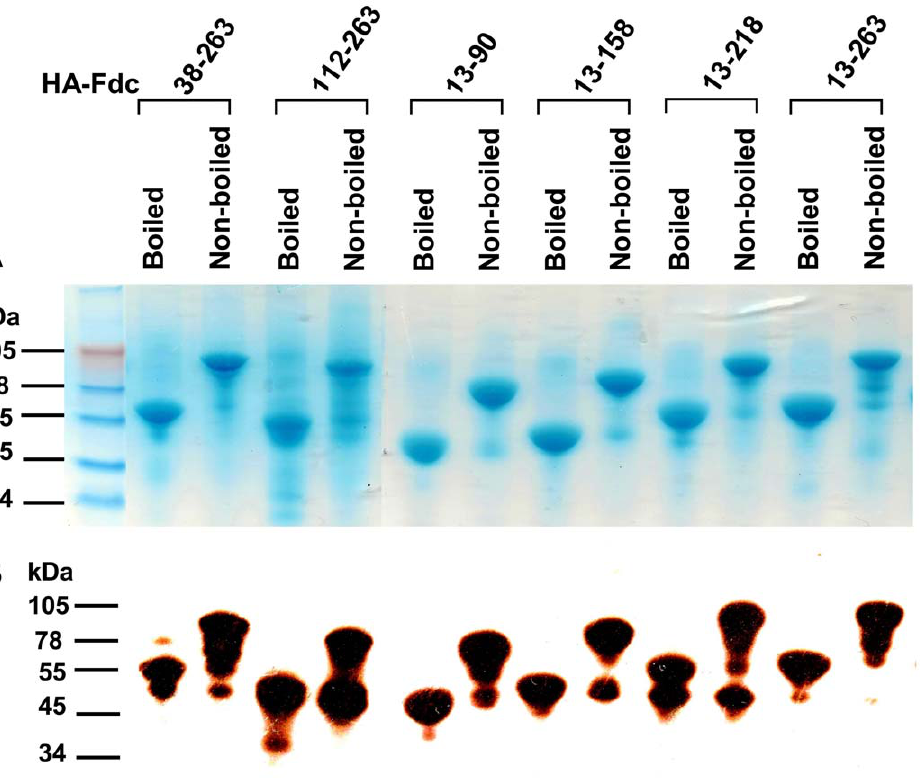
Figure 2. SDS-PAGE and Western blot analysis of expressed proteins containing truncated HA1 fragments. Protein samples were either boiled at 95 u C for 5 min, or not boiled, followed by addition of 6 6 SDS-PAGE sample buffer. SDS-PAGE with Coomassie Blue staining was then run (A), as well as Western blot (B) by using a HA1-specific mAb. The protein molecular weight marker (kDa) (Invitrogen) is indicated on the left.